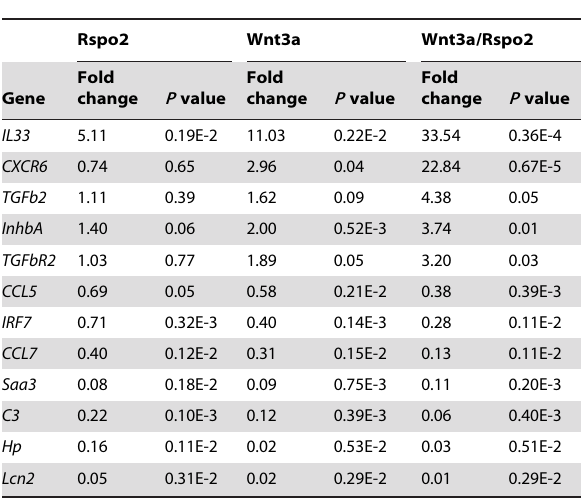
Table 1. Microarray data of known Wnt/ b -catenin target genes validated by qRT-PCR.